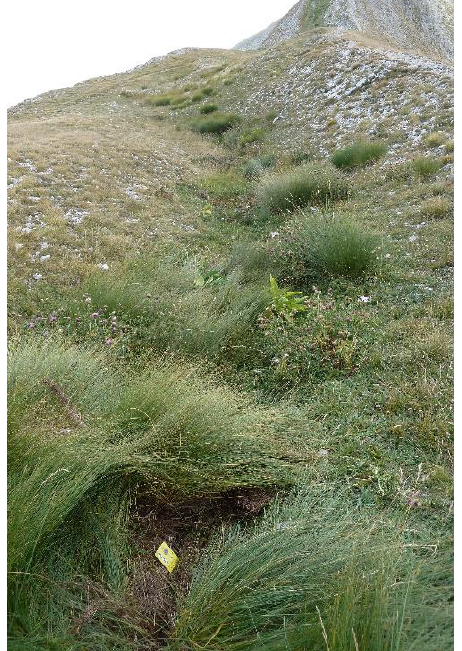
Figure 5 – Fractures and cracks observed along the bottom of the double ridge of Monte